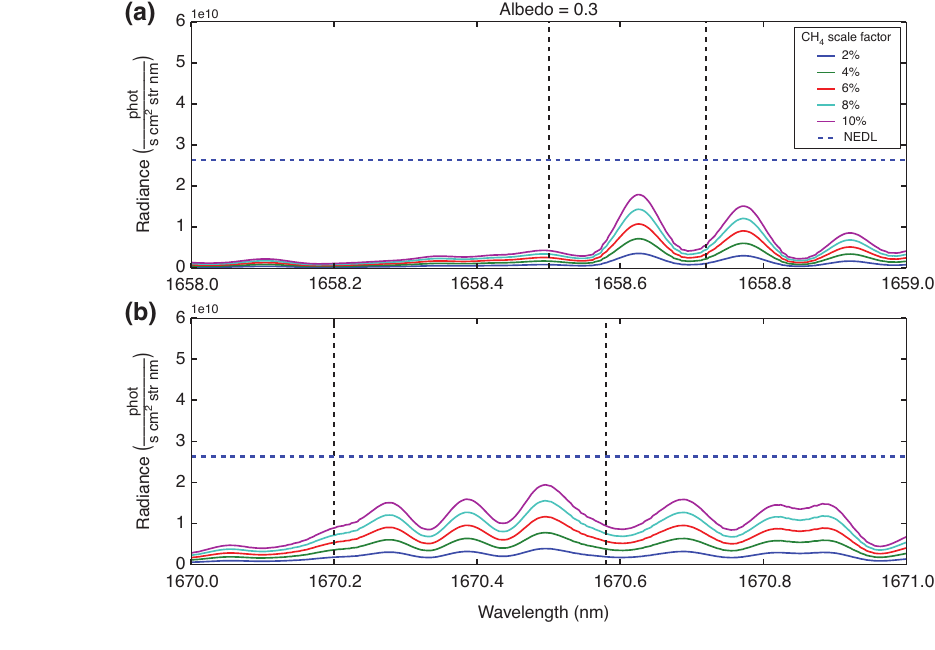
not the individual peaks highlighted in Fig. 4 will exceed the NEDL. Figures 7 and 8 show example results for two different surface albedos, for all the proposed methane concentration levels.